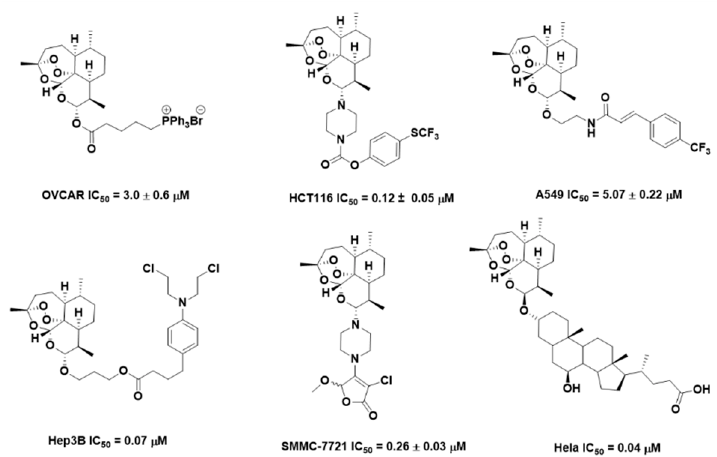
Figure 1. Successful modification of novel artemisinin derivatives or hybrids.